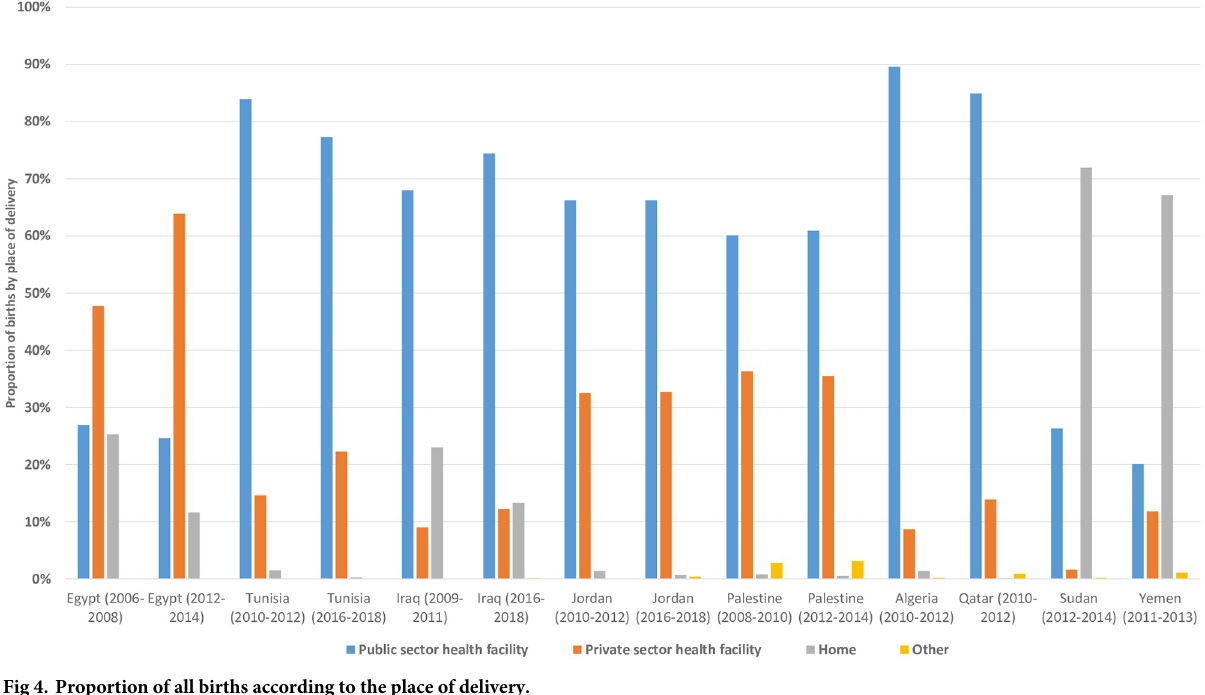
Fig 4. Proportion of all births according to the place of delivery.